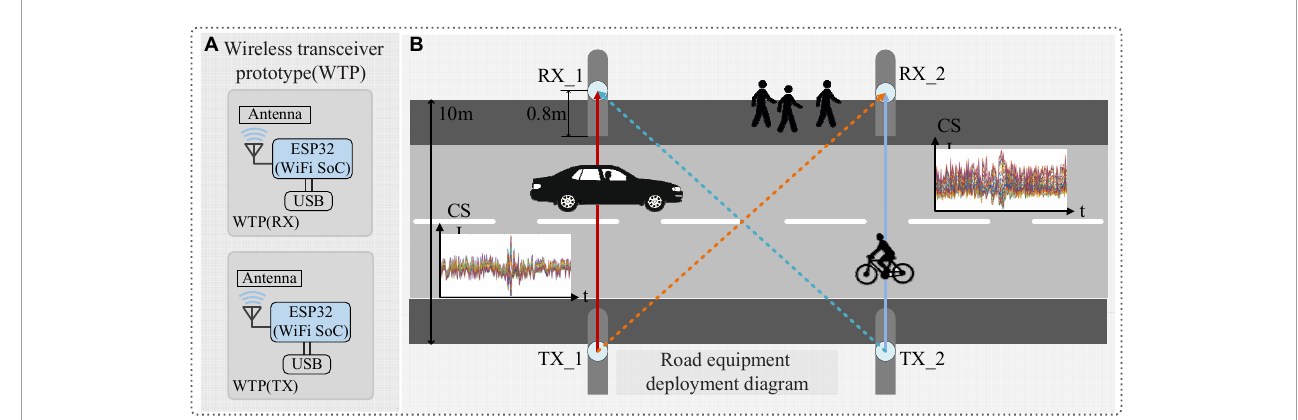
FIGURE1 System architecture of the proposed WiHVR method. (A) Wireless transceiver prototype (WTP). (B) Road equipment deployment